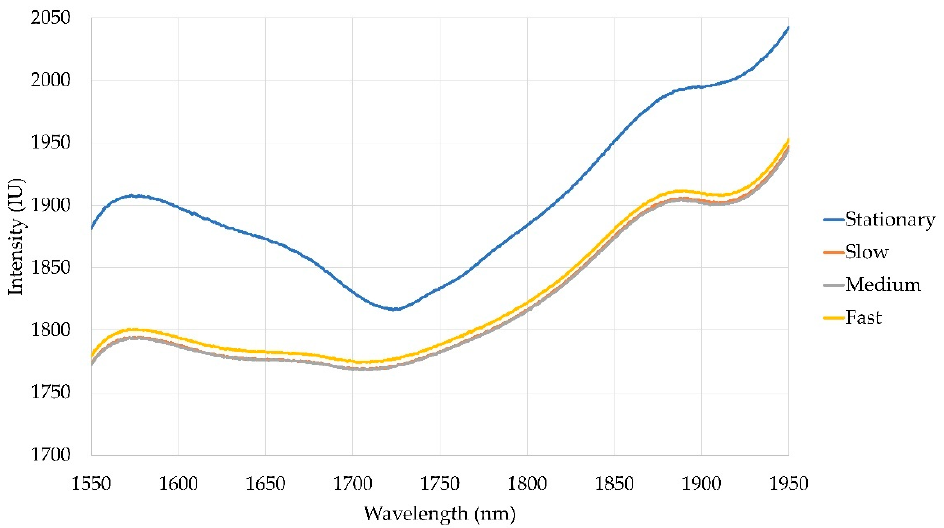
Figure 4. Plots of the average spectra for barley flour under stationary and each moving condition (slow—0.017 ms − 1 , medium—0.036 ms − 1 , fast—0.068 ms − 1 ).